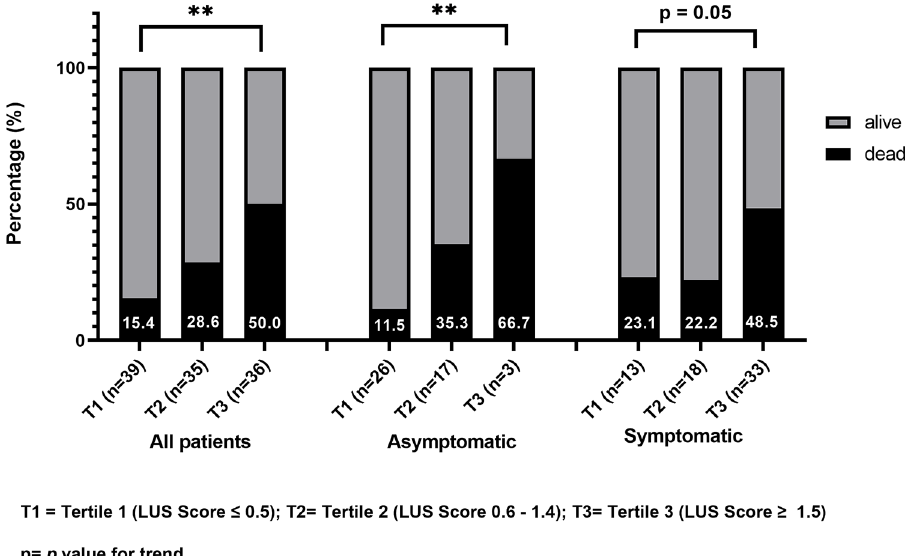
Figure 4. Three-months all-cause-mortality of older patients with SARS-CoV2 infection according to LUS score tertiles. **p-value <